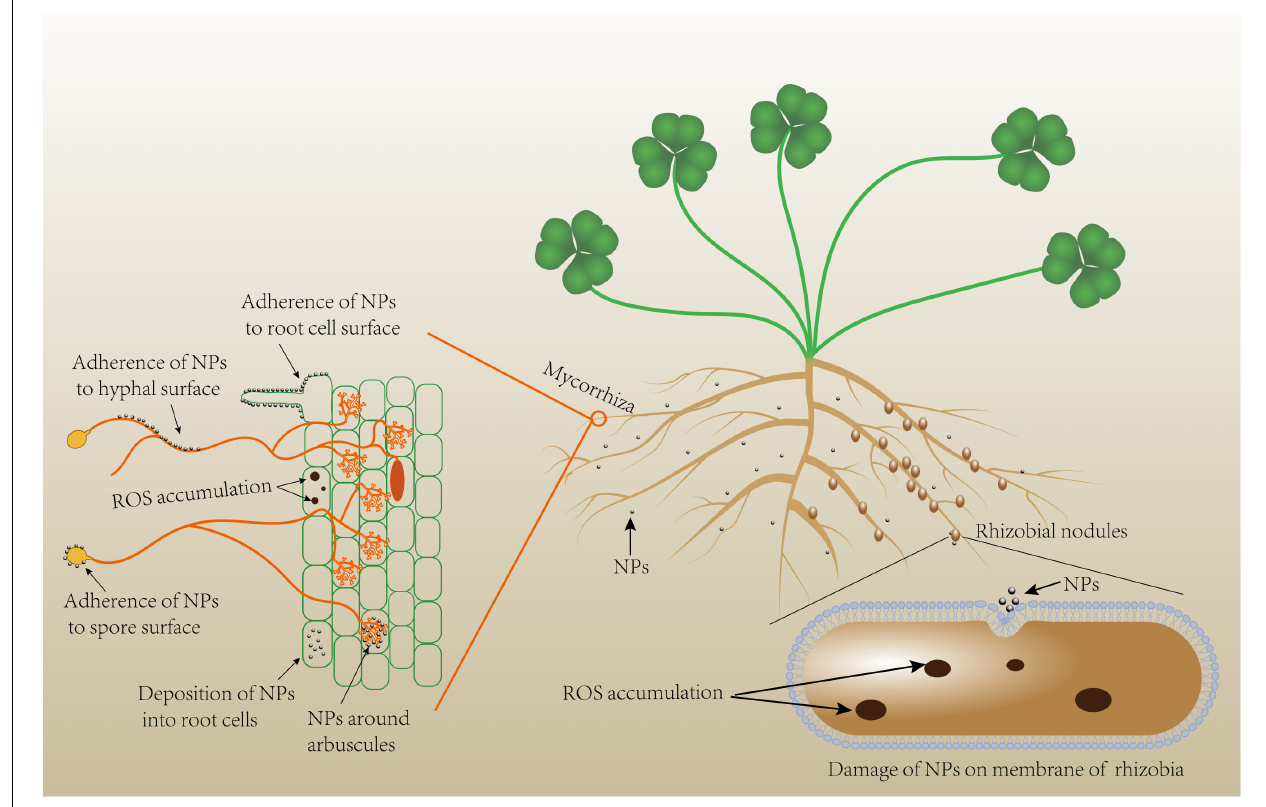
FIGURE 2 | A theoretical demonstration of NPs exposure to roots, and root microbial symbionts. ROS, reactive oxygen